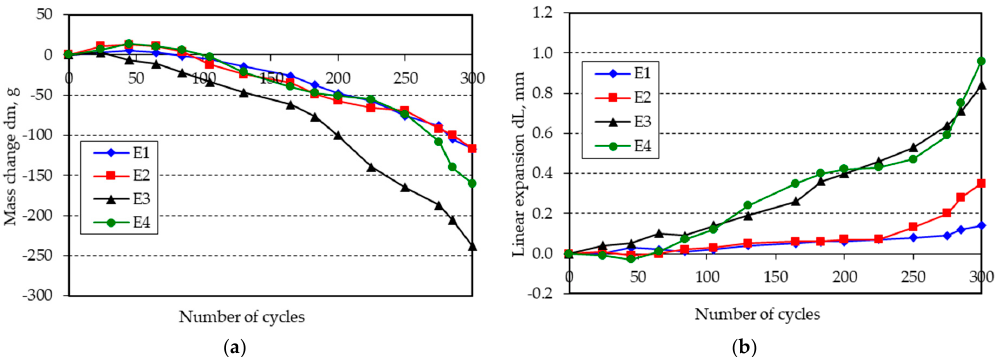
Figure 5. ( a ) Mass change; ( b ) linear expansion of specimens E1–E4 following freezing and thawing in water.